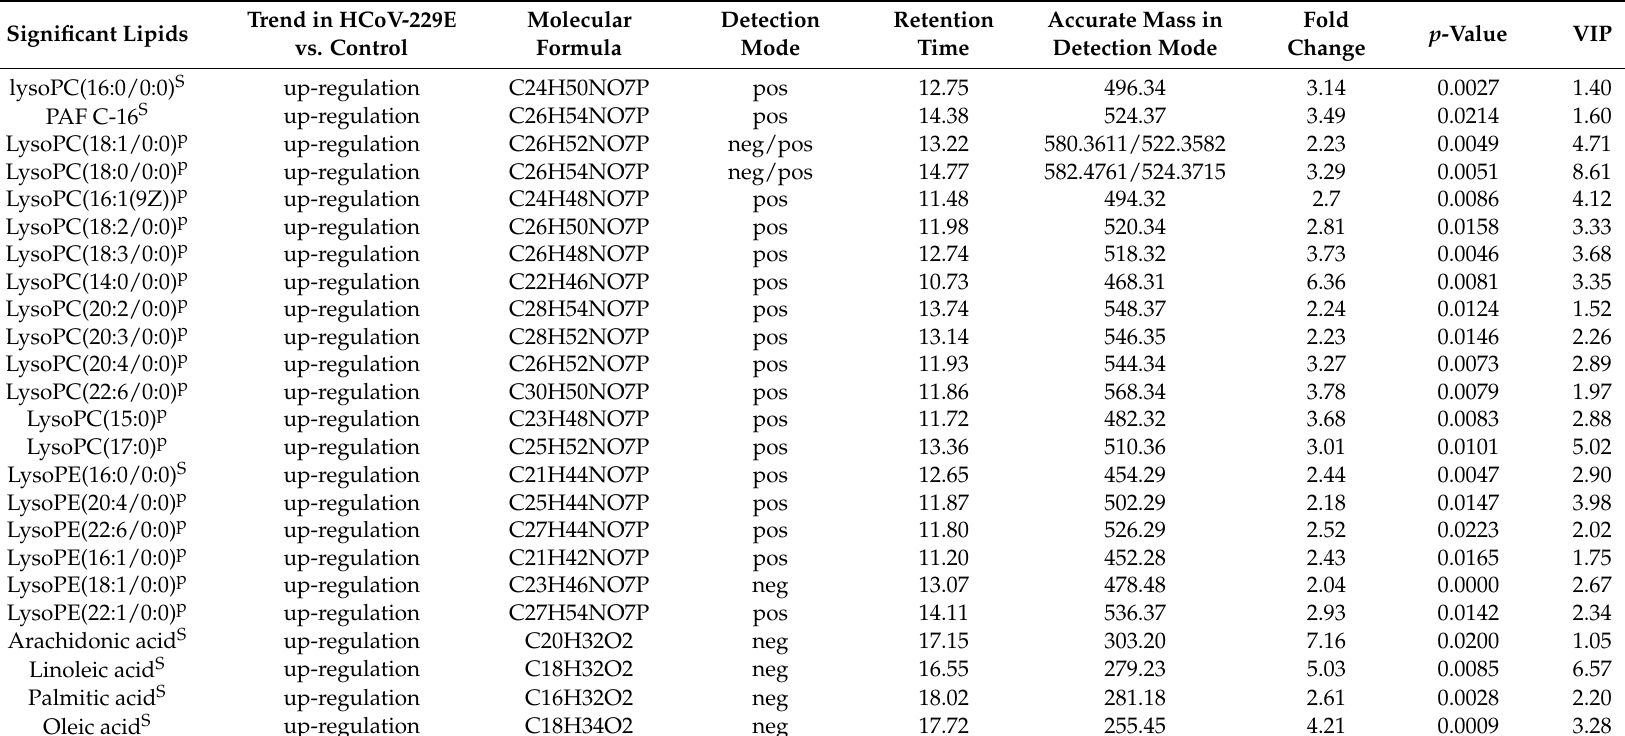
Table 1. The 24 lipids that were significantly different between HCoV-229E-infected and mock-infected